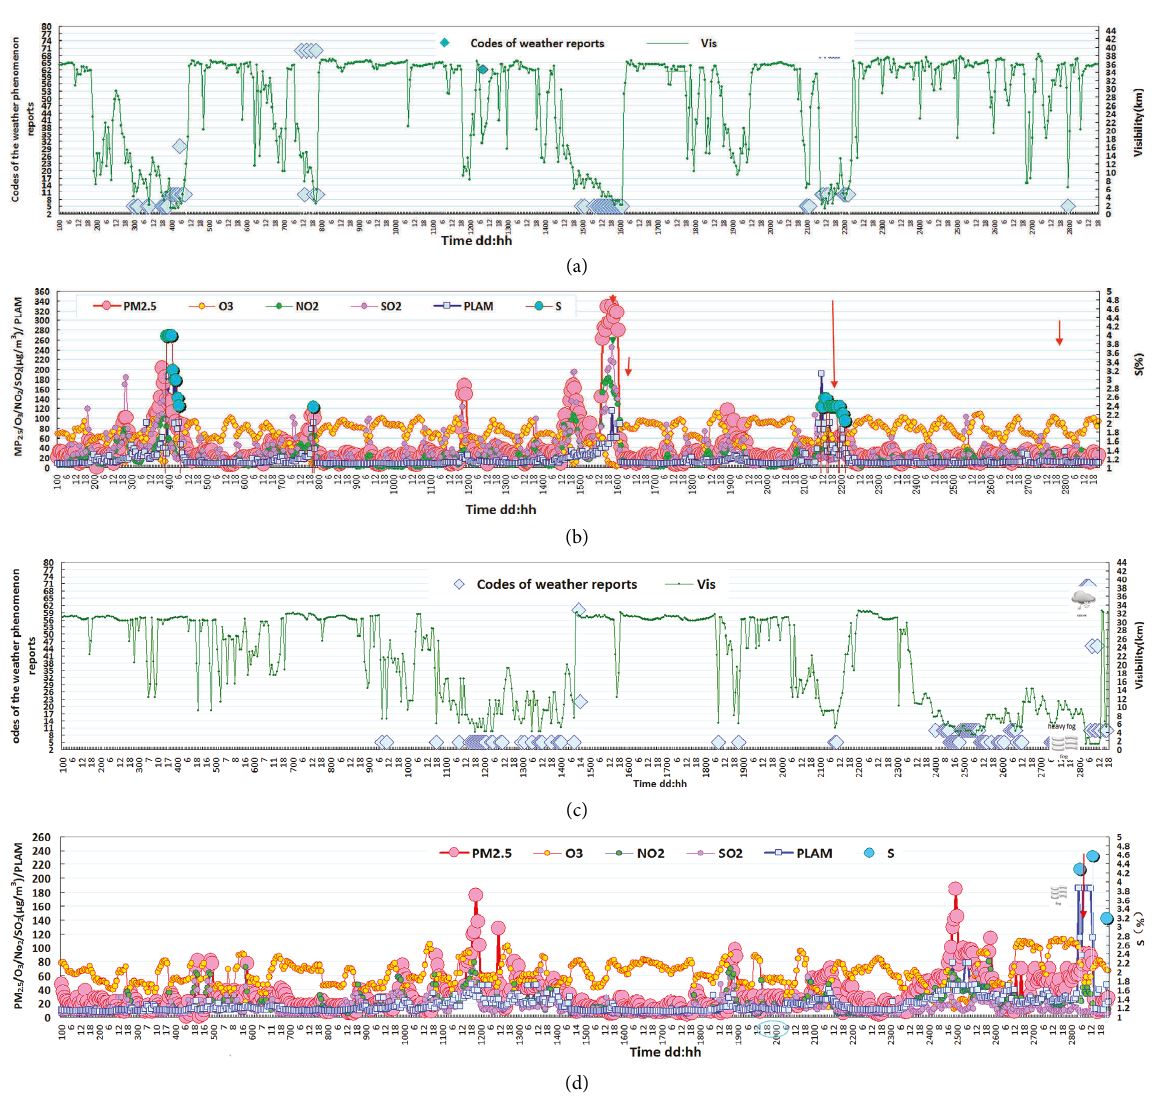
Figure 4: Hourly distributions of visibility and fog–haze pollution in Zhangjiakou for February 1–28, (a) 2017 and (c) 2021; hourly observed distributions of PM 2.5 , O 3 , NO 2 , SO 2 , the PLAM index, and low-level atmospheric supersaturation(S) for February 1–28, (b) 2017 and (d)